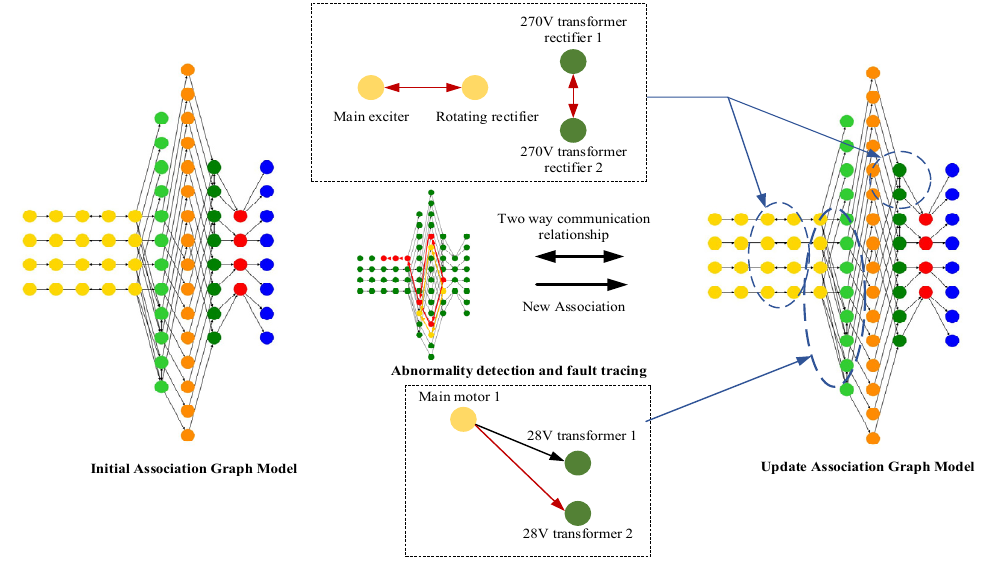
Figure 10. The power supply system’s association graph